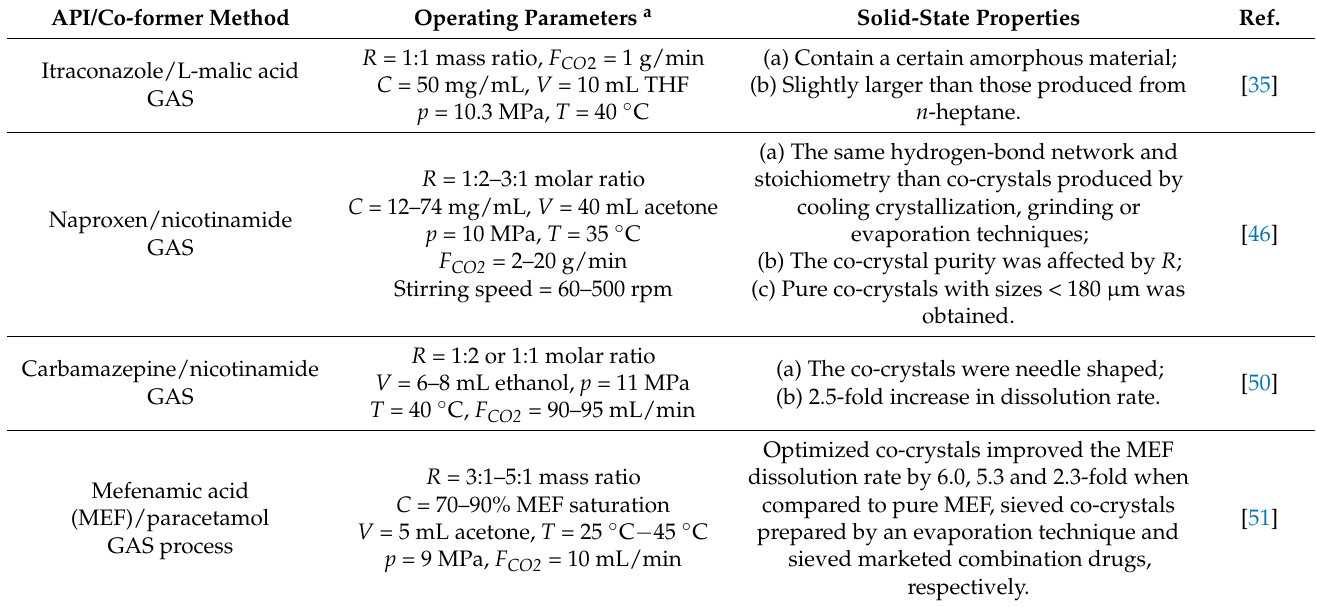
Table 1. Examples of pharmaceutical co-crystals prepared via the SAS